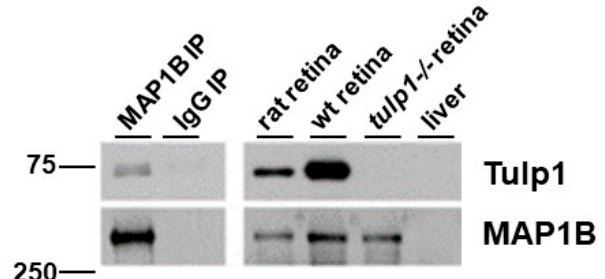
Figure 2. IP of retinal lysate. The top panels show Western blot analysis of the MAP1B IP experimental samples probed with Tulp1 antibodies. In the IP product lane, a band corresponding to Tulp1 is detected. A corresponding band is seen in the rat retinal lysate and wt mouse retinal homogenate but not in the tulp1 − / − retinal lysate, liver lysate or non-specific IgG IP lanes. The bottom panels show Western blot analysis of the MAP1B IP experimental samples probed with MAP1B antibodies. In the IP product, rat retinal lysate, wt mouse retinal lysate and tulp1 − / − retinal lysate lanes, a band corresponding to MAP1B is detected. No bands are seen in the liver or non-specific IgG IP sample lanes.